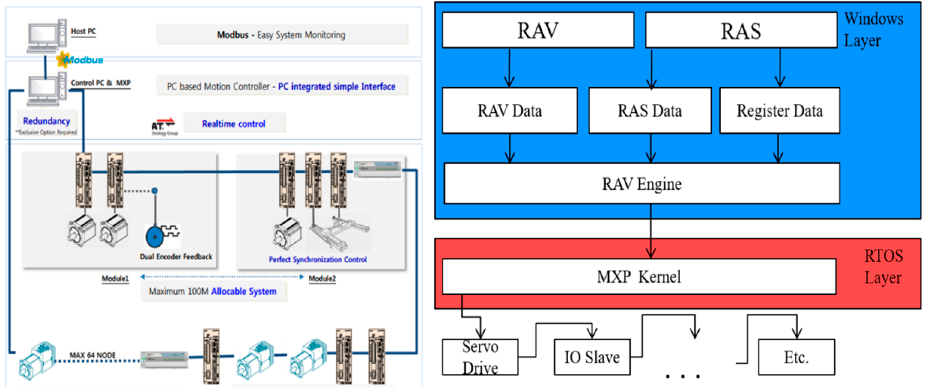
Figure 6. Configuration and structure of 3DCP control system